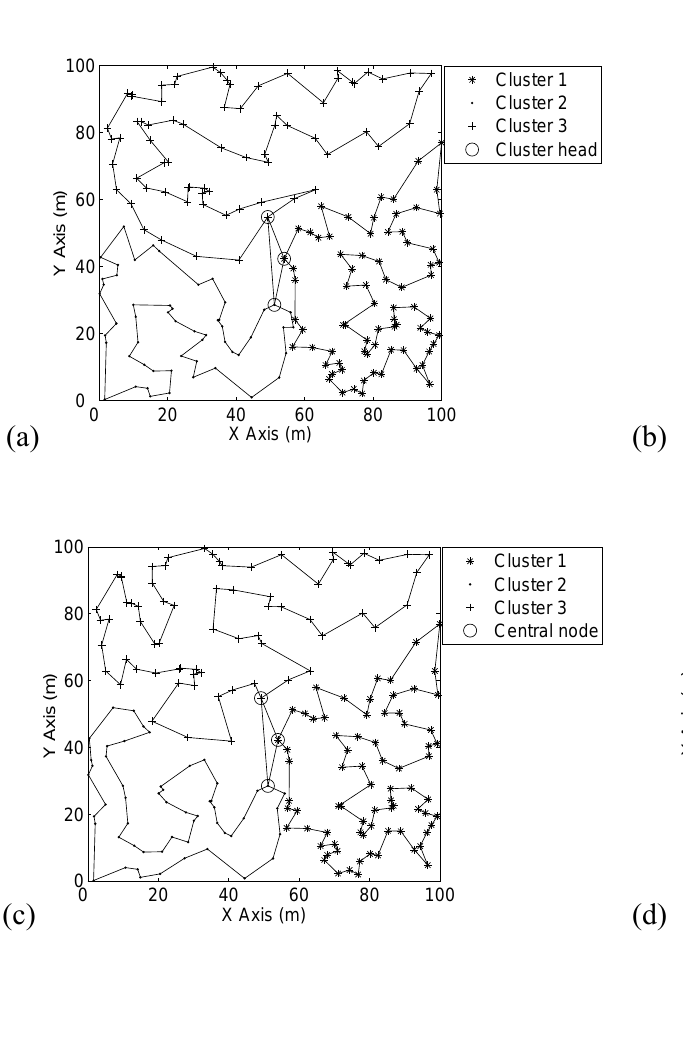
Figure 6. The routing and clustering results of (a) ACO-TSP, (b) SA-MTSP, (c) GA-MTSP, and (d) ACO-MTSP with the following